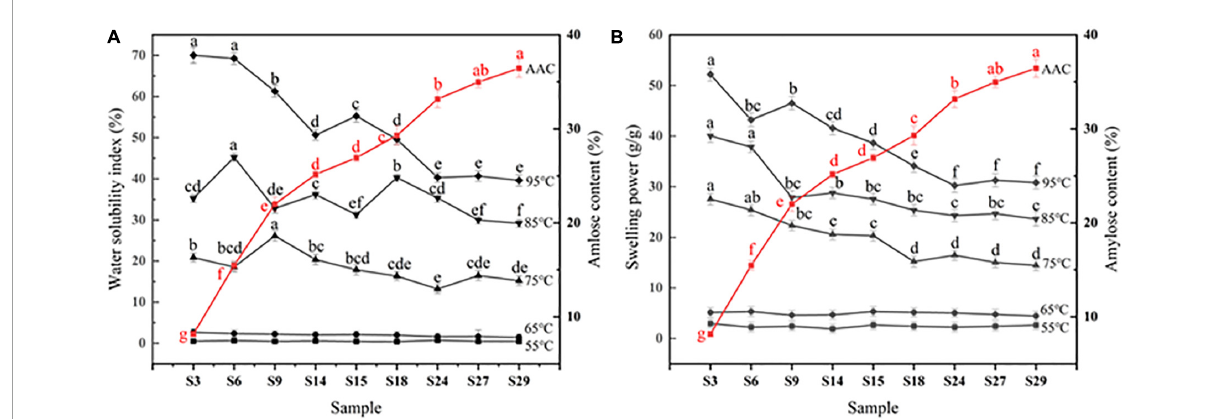
FIGURE3 (A) Trends of water solubility index of sorghum starch with amylose content. (B) Trends of swelling power of sorghum starch with amylose content. S3–S29 are sorghum starch with gradually increasing amylose content. a–f: Different letters indicate significant differences ( p < 0.05). There was no significant difference between different starches at 55 and 65 ◦ C.